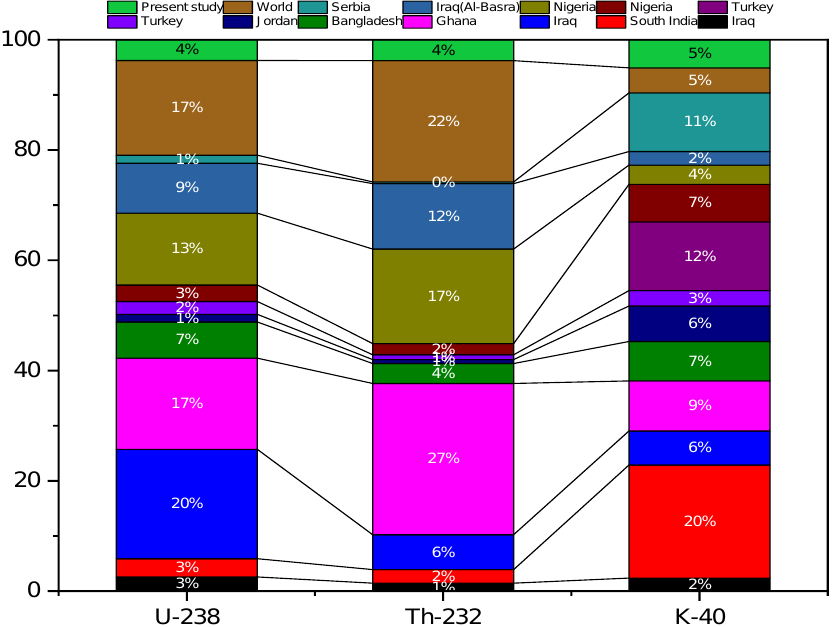
Figure 5. The mean activity concentrations of natural radioactivity of medicinal plant samples in the present study were compared with those from similar investigations performed in other